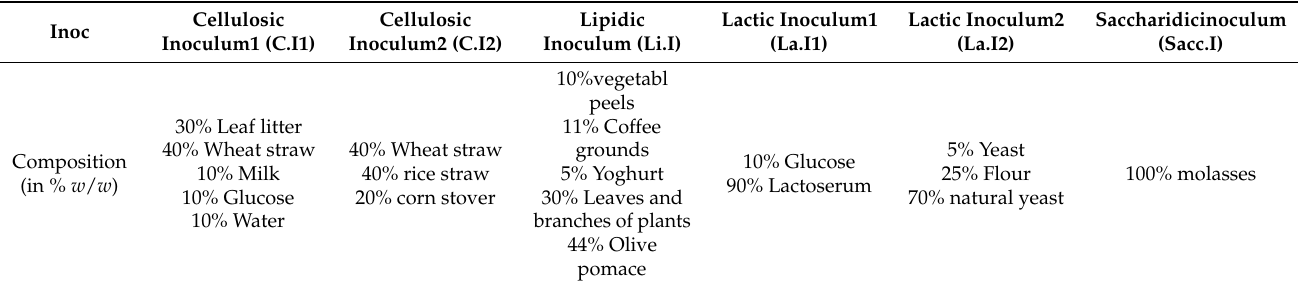
Table 1. Composition of the inoculum used for anaerobic digestion.